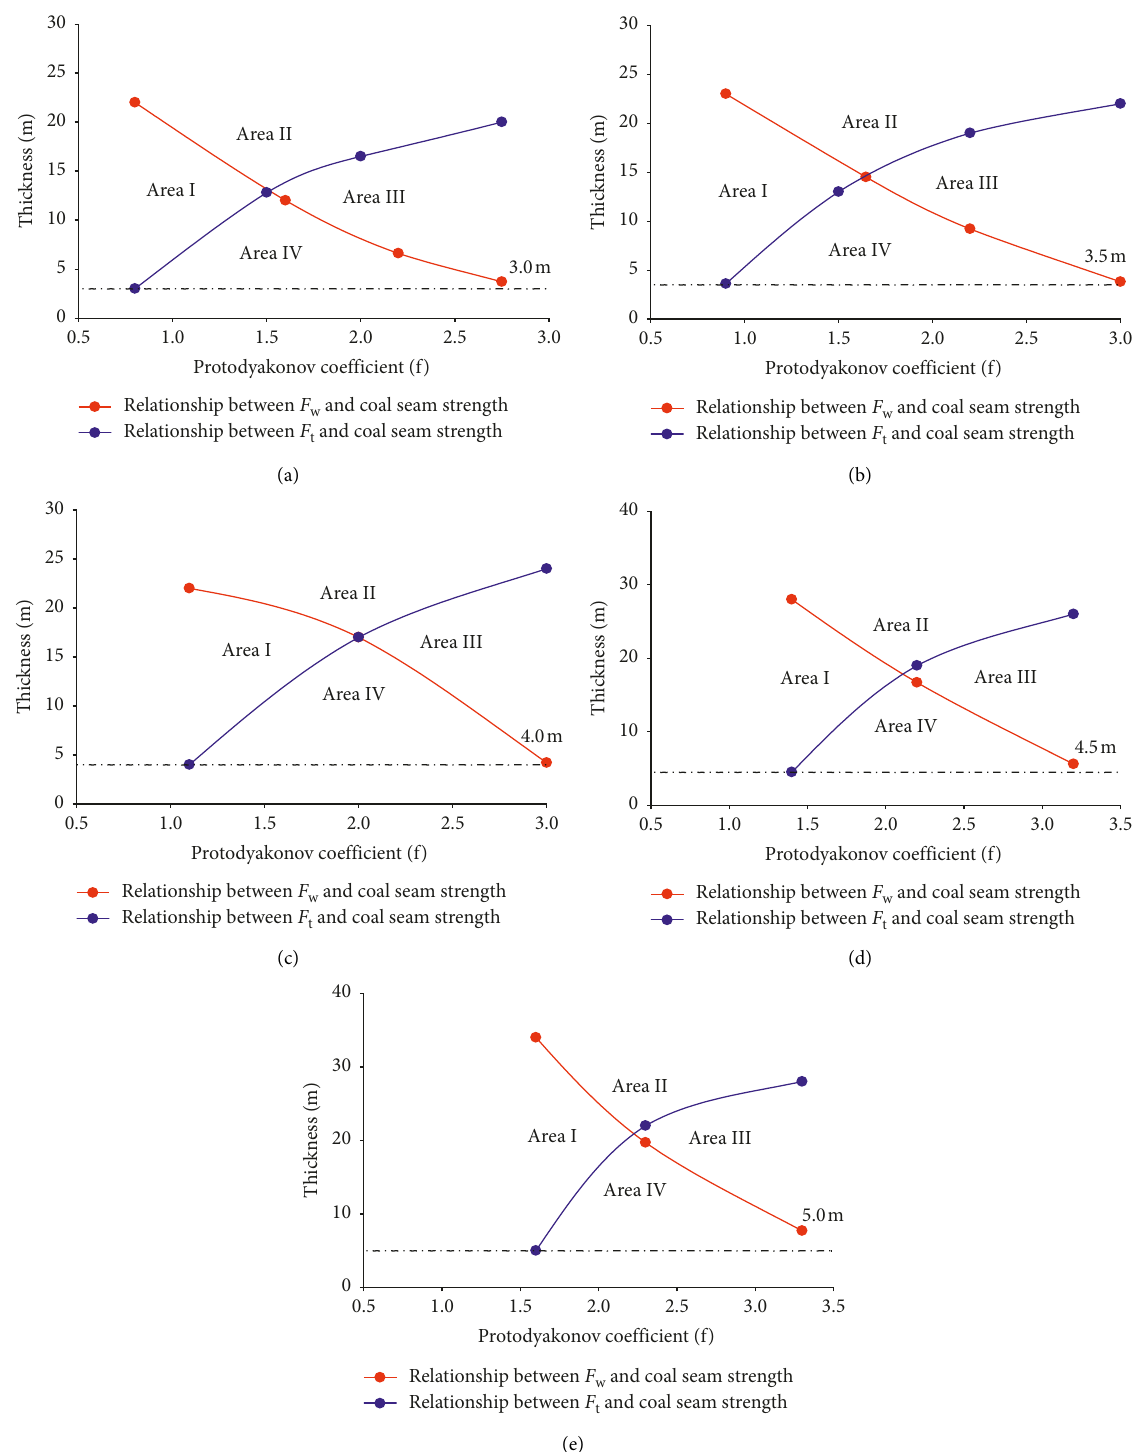
Figure 6: The interaction relationship between the coal seam strength and the top-coal thickness under different cutting